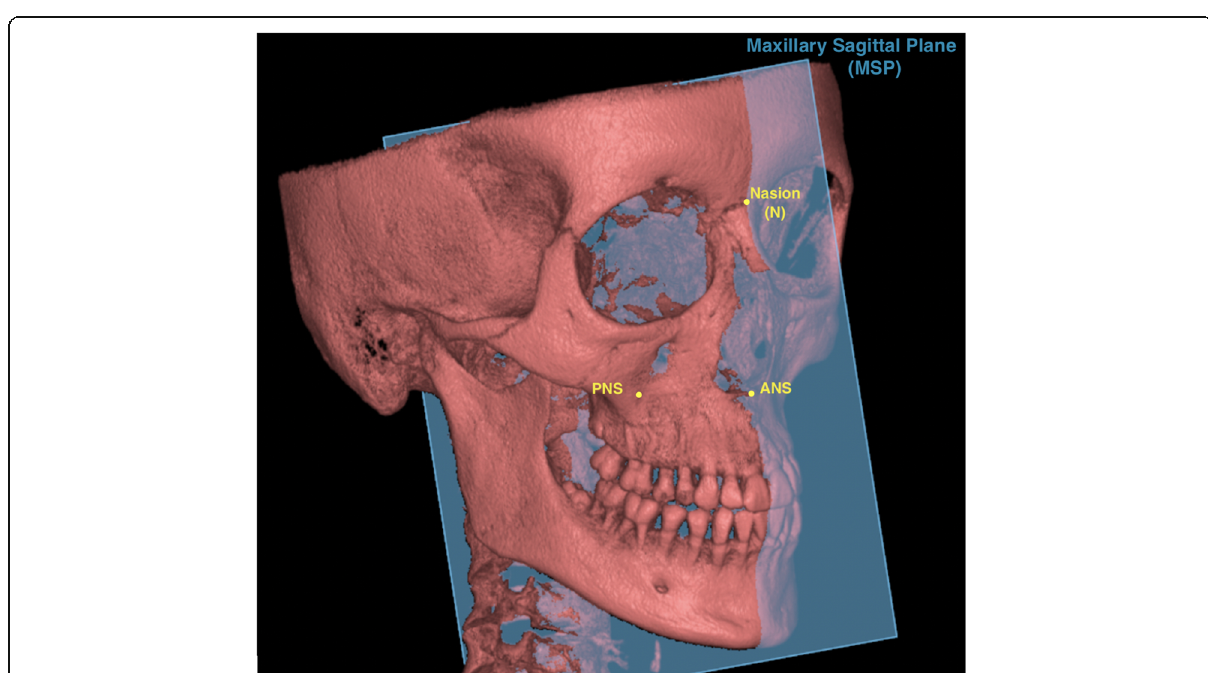
Fig. 4 3D demonstration of reference planes. Maxillary sagittal plane (MSP) passing through anterior nasal spine (ANS), posterior nasal spine (PNS), and nasion (N) on the preexpansion CBCT